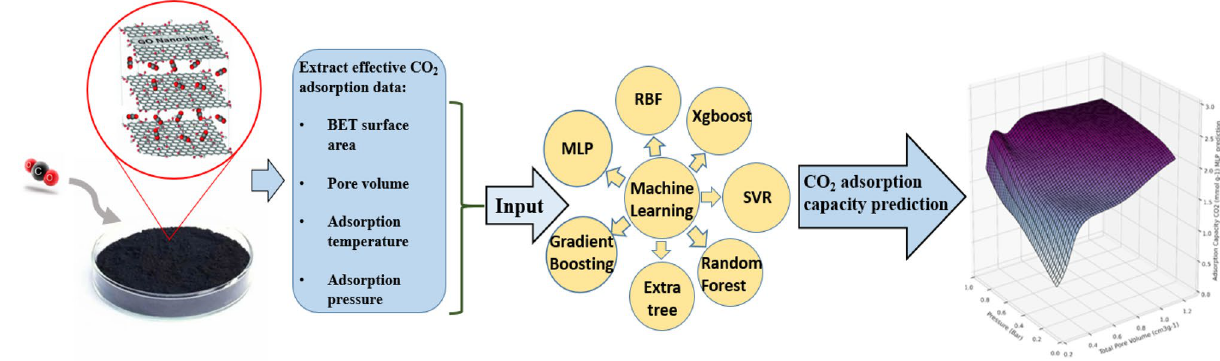
Figure 1. The general sketch of this research